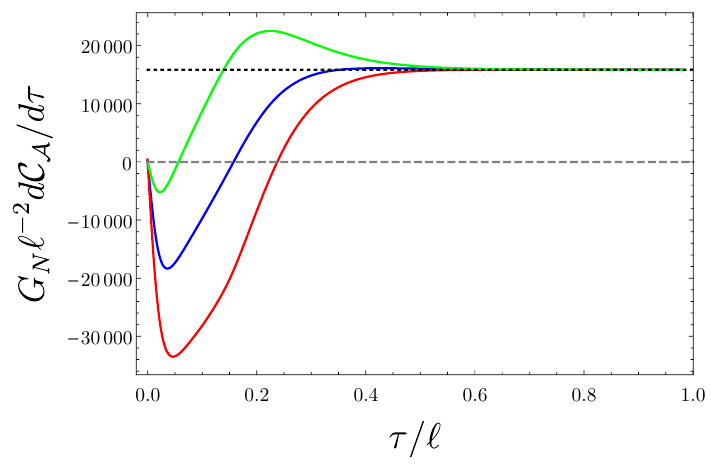
Figure 12. Here we show a plot of the growth rate of complexity for the parameter choices r + /‘ = 10 , r − /r + = 1 / 10 for the choices ‘ ct = 10 , 1 , 1 / 10 corresponding to red, blue, green curves, respectively — or bottom to top. The dotted black line shows the growth rate of complexity in the limit τ → ∞